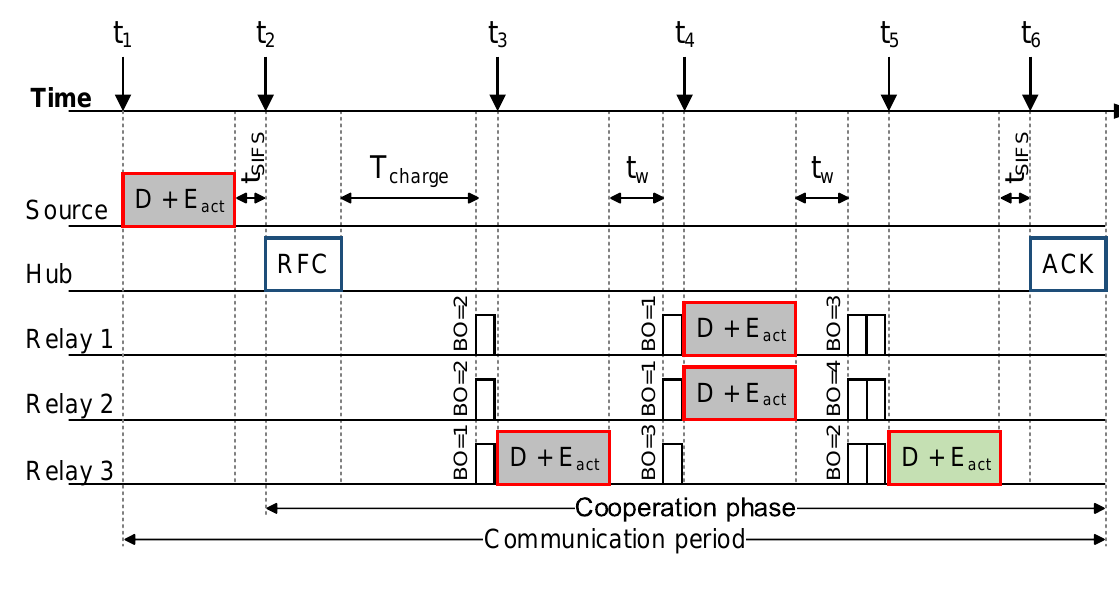
Figure 3. Operational